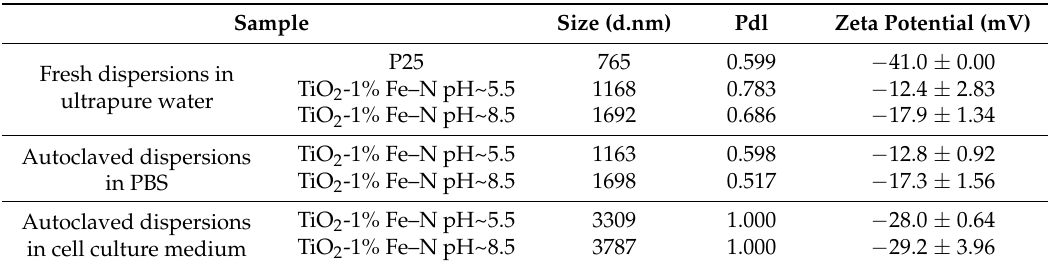
Table 4. The Z -average, polydispersity index (PdI) and zeta potential values measured for fresh and autoclaved particle dispersions.